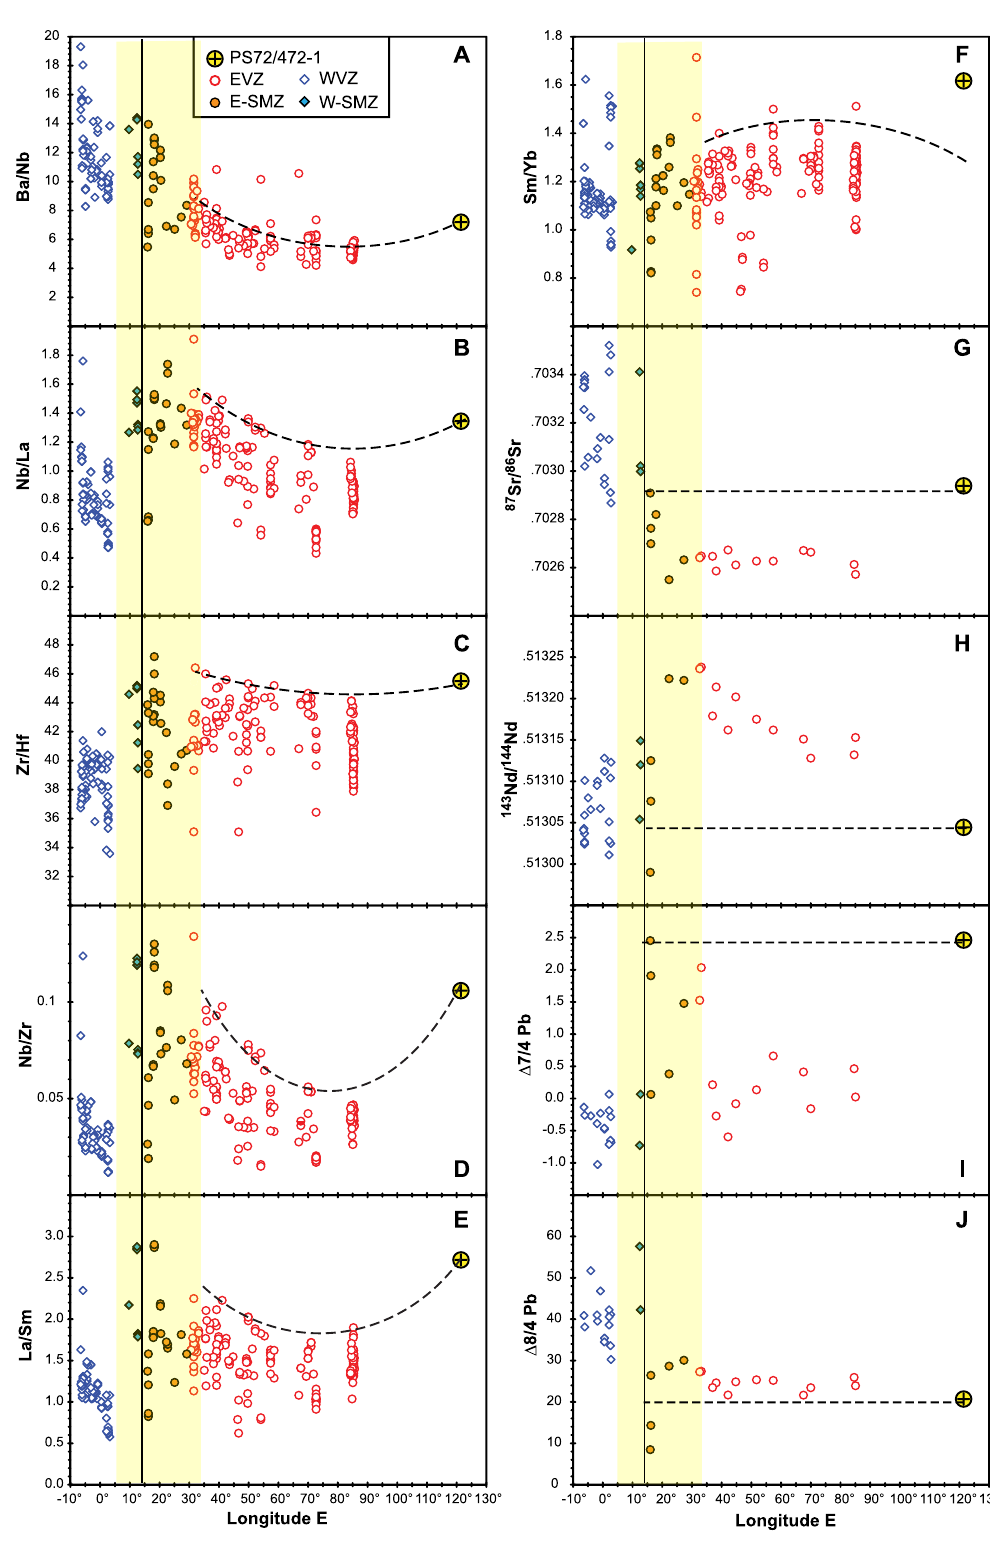
Fig. 7 Geochemical trends along the Gakkel Ridge. Along ‐ axis variations of incompatible element ratios of A Ba/Nb, B Nb/La, C Zr/Hf, D Nb/Zr, E La/Sm, and F Sm/Yb in Gakkel lavas and long ‐ axis variations of G 87 Sr/ 86 Sr, H 143 Nd/ 144 Nd, and Pb isotopes expressed as I Δ 7/4Pb and J Δ 8/4. The Delta ( Δ ) notation re fl ects deviations from typical compositions of Paci fi c and Atlantic MORB on 208 Pb/ 204 Pb – 206 Pb/ 204 Pb diagrams 28 . Note that the majority of Gakkel melts are tholeiitic, while alkaline melts are infrequent but occur in each segment 10 . The vertical line marks the isotopic boundary at ~14°E 18 . The dashed line shows maximum incompatible element enrichment and variation in 87 Sr/ 86 Sr, 143 Nd/ 144 Nd, and Pb isotopes discussed in the text. The fi gure is adapted from ref. 10 , their Fig. 5 and is based on published data of volcanic glasses (compilation of ref. 58 ) and melt inclusions (refs. 32,59 ) and a basalt sample from the GRD 10